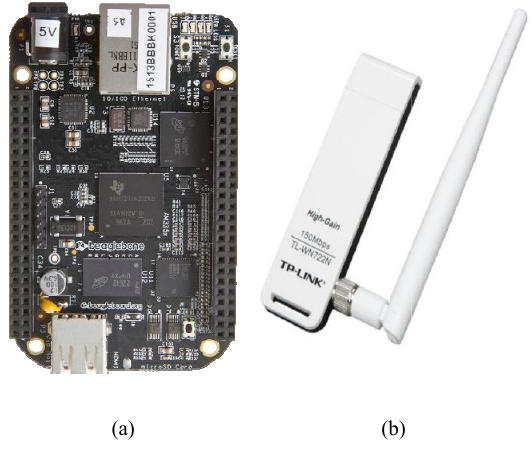
Fig. 1. Devices used in the experimental tests : (a) Beaglebone Black; (b) WiFi USB adapter TP- Link TL